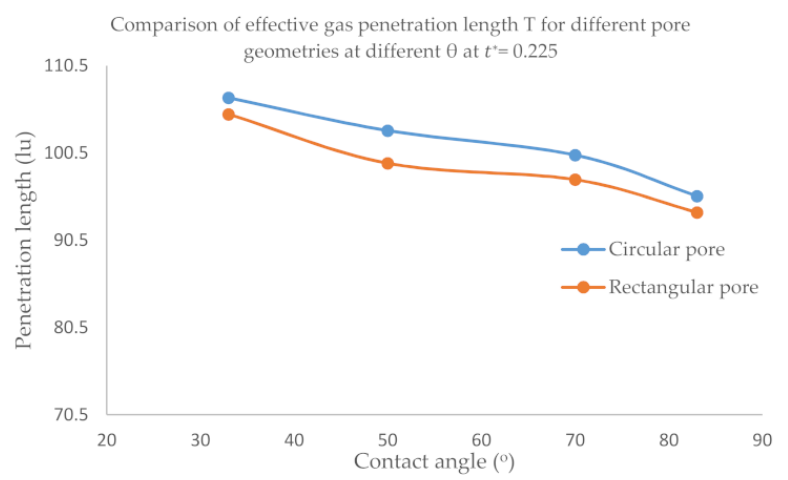
Figure 13. Comparison of effective gas penetration length T for different pore geometries at different θ at t ∗ =